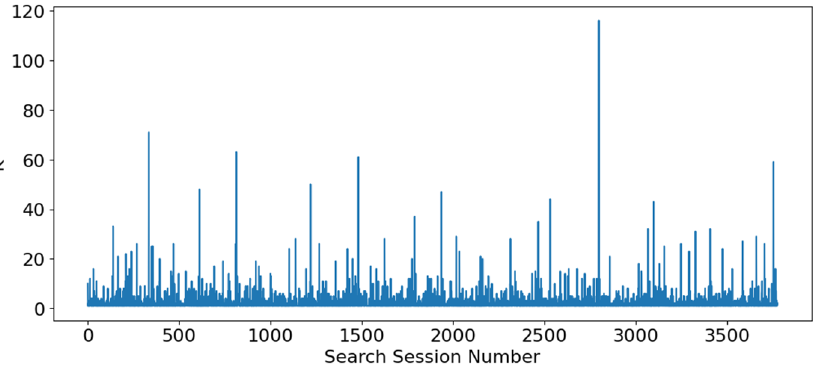
Figure 2. K values for 4000 sessions: during some sessions, many articles are read ( K ) but in most cases, only a few articles are retrieved. On average, 2.7 articles are downloaded, 75% of the sessions are for three papers or less, some sessions exceed 100 items.